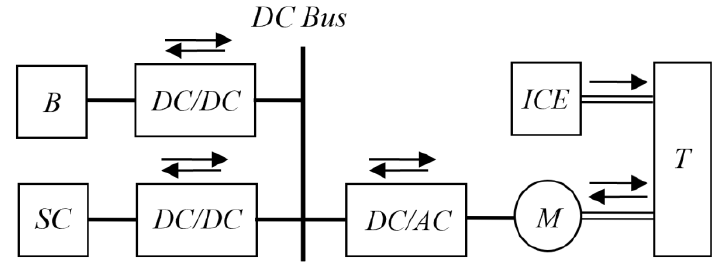
Figure 1. Combined vehicle system with ICE as the main energy source.